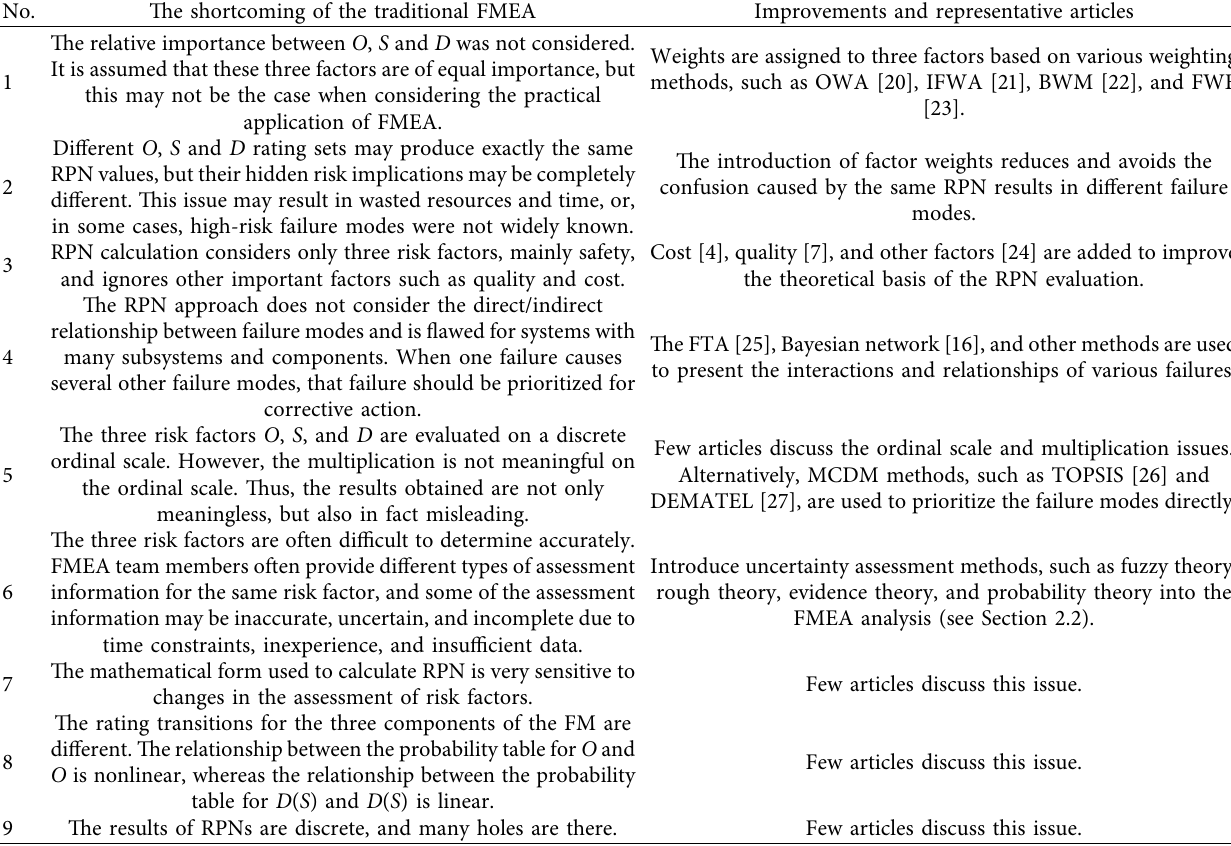
Table 1: Deficiencies of traditional FMEA and measures to improve